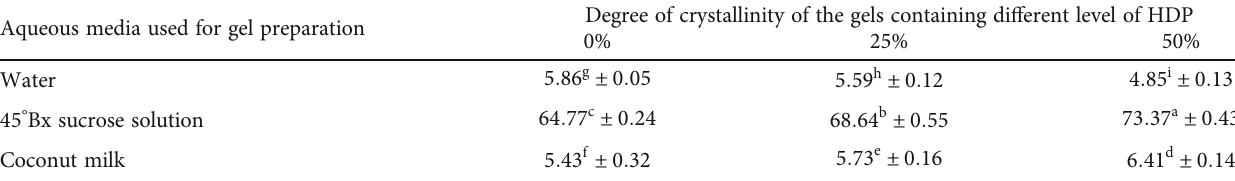
Table 3: Degree of crystallinity of the starch gels stored at 4 ° C for 21 days. Degree of crystallinity of the gels containing di ff erent level of HDP Aqueous media used for gel preparation